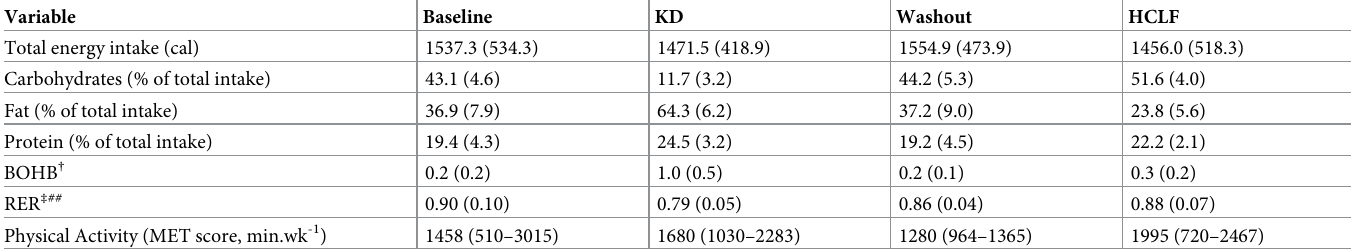
Table 2. Macronutrient energy intake, blood β -hydroxybutyrate (BOHB), and respiratory exchange ratio (RER) after the habitual diets of baseline and washout, and after the ketogenic diet (KD) and high-carbohydrate low-fat (HCLF) diet, for the whole cohort (n = 11).